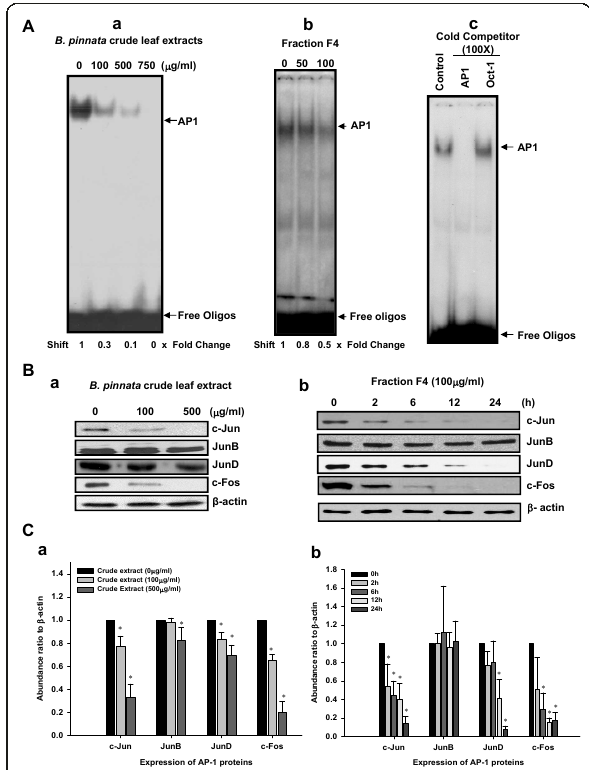
Figure 3 Effect of B. pinnata crude leaf extract on AP1 specific DNA-binding and expression of its constituent subunits in cervical cancer cells . A . Nuclear proteins (10 μ g/lane) of HeLa cells treated with indicated concentrations of B. pinnata crude extracts (a) or its fraction F4 (b) for 24 h and were assayed for AP1 DNA binding activity by EMSA. Untreated HeLa nuclear proteins and labeled AP1 probe were incubated in the presence of 100 fold molar excess of unlabeled homologous AP1 probe or heterologous Oct-1 probe and assayed for AP1 specific binding by EMSA (c) . Fold change was calculated following densitometric evaluation of shifted band. B . Effect of B. pinnata leaf extracts on the expression of AP1 family proteins. Representative immunoblots of cellular proteins isolated from HeLa cells treated with B. pinnata crude leaf extract (a) and fraction F4 (b) as indicated showing expression of different members of AP1 family. b